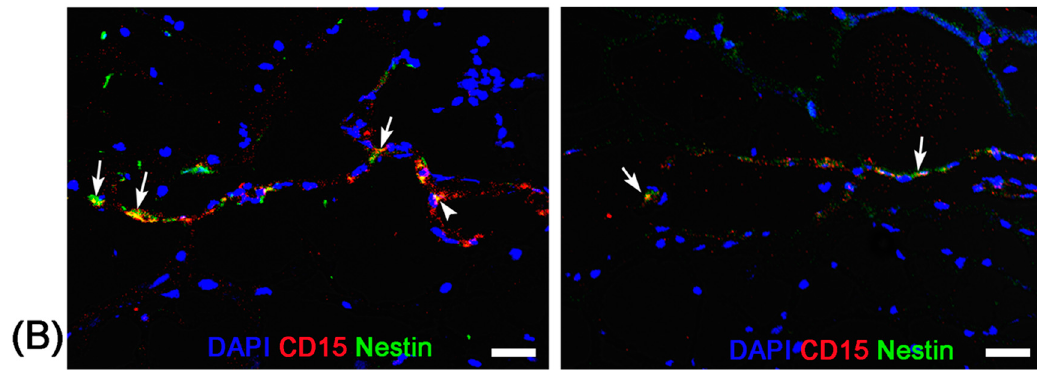
Figure 5. Immunofluorescence studies of the activation of endogenous NSCs. Representative anti-CD15 (red) and anti-Nestin (green) immunofluorescence staining micrographs show the presence of CD15 + Nestin − and CD15 + Nestin + cells in the SVZ (arrows) and beginning of RMS (arrowheads) before the establishment of stroke both in pure stroke mouse ( A ) and Ara-C-treated mouse ( B ). There are abundant CD15 + Nestin − and CD15 + Nestin + cells in the SVZ and RMS in pure stroke animals eight days after stroke. Almost no CD15 + Nestin − or CD15 + Nestin + cells are present in stroke animals after administration of Ara-C for seven days. Bars = 25 μ m.